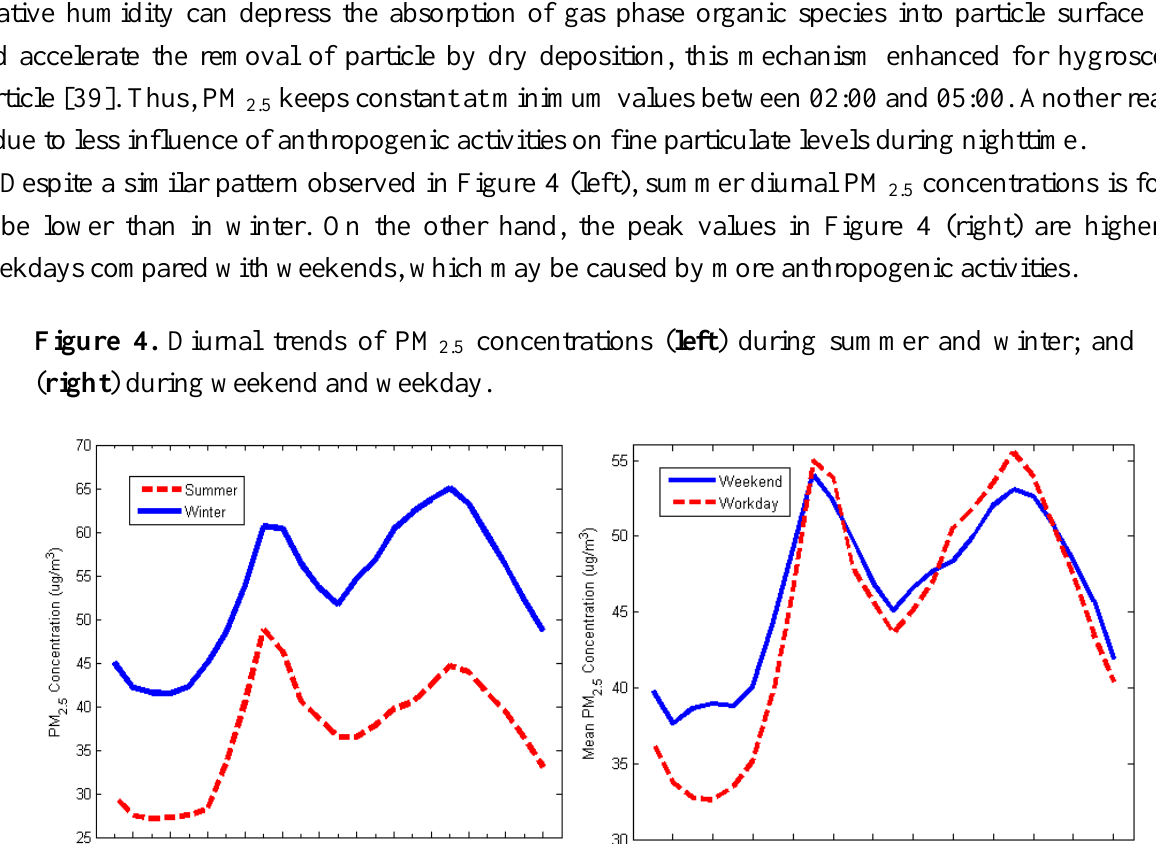
Figure 5. Seasonal variations of PM